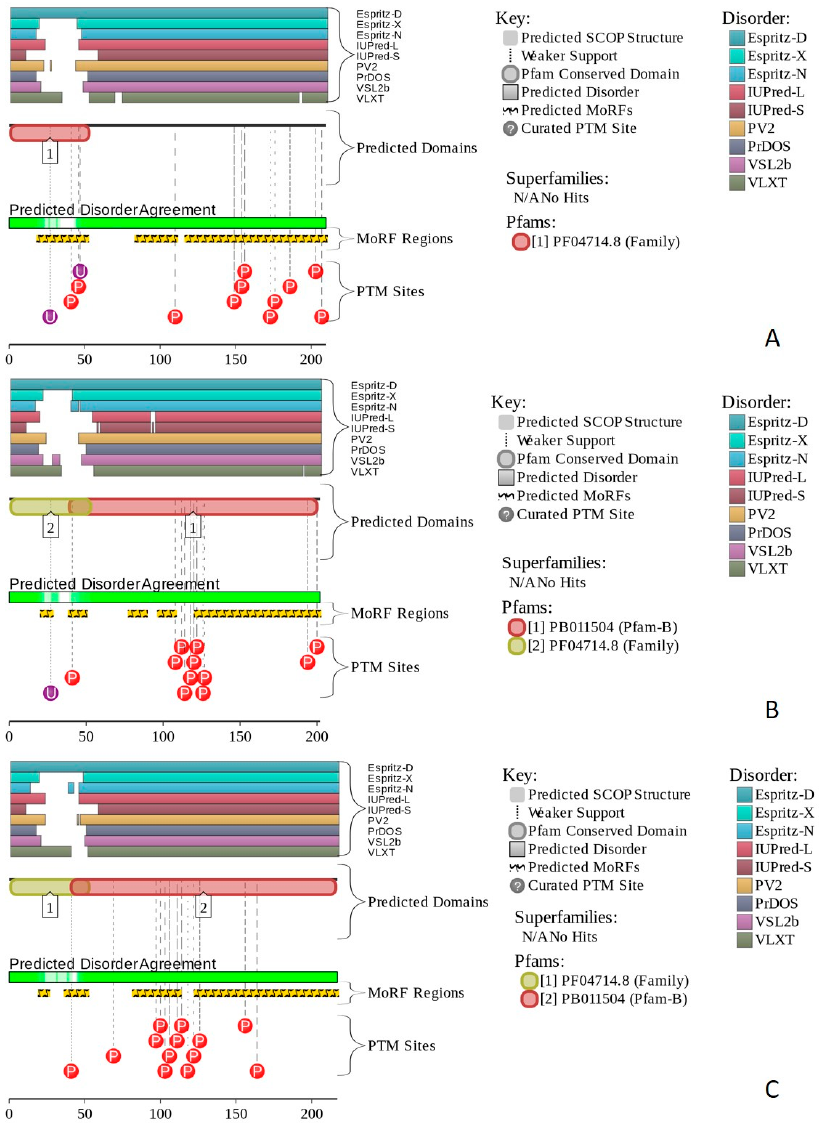
Figure 14. Intrinsic disorder and functionality of human BCL7A (UniProt ID: Q4VC05) ( A ), BCL7B (UniProt ID: Q9BQE9) ( B ), and BCL7C (UniProt ID: Q8WUZ0) ( C ) as evidenced by the D 2 P 2 platform.